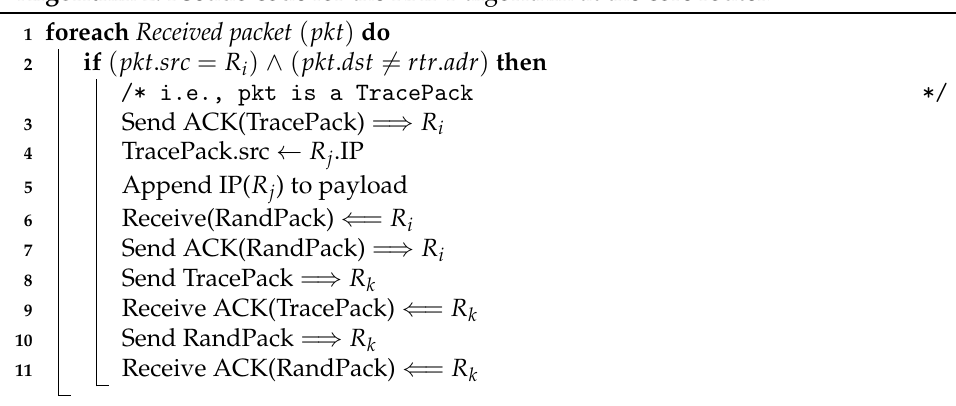
Algorithm 2: Pseudo code for the RAPT algorithm at the core